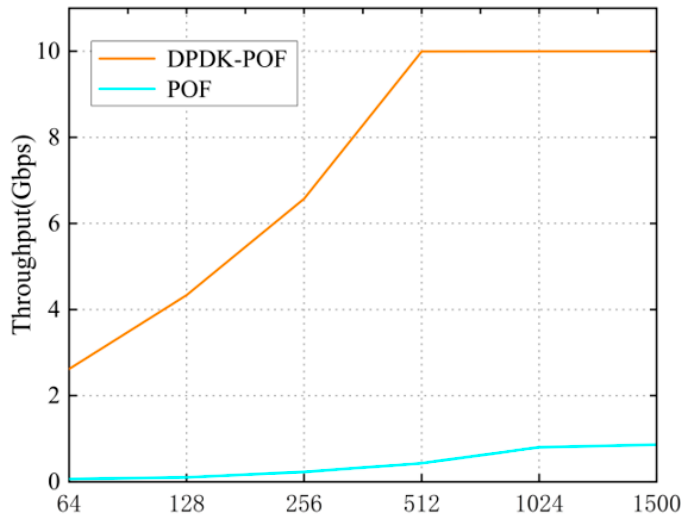
Figure 11. Packet forwarding throughput.